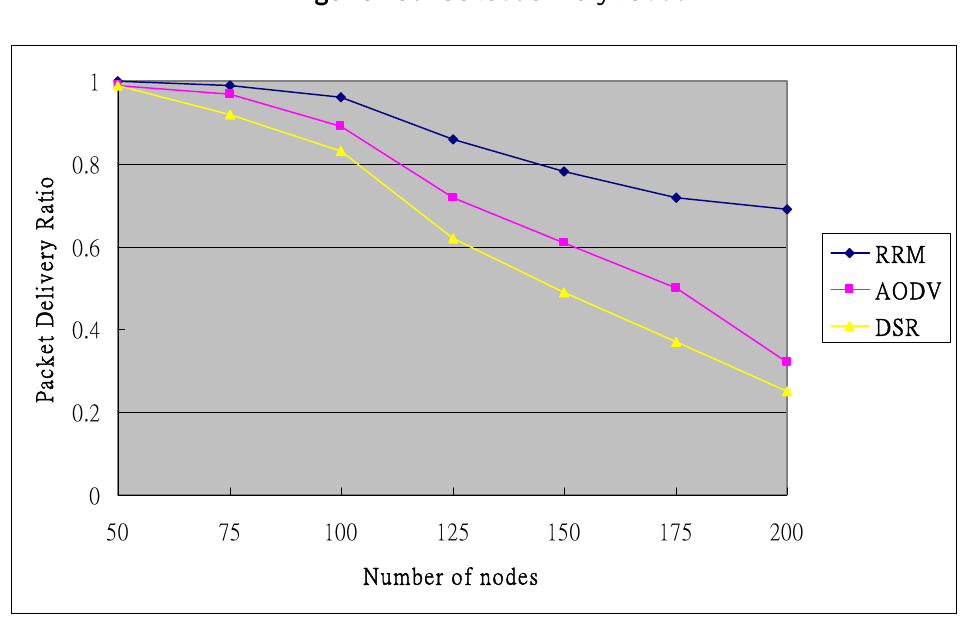
Figure 15. Packet delivery